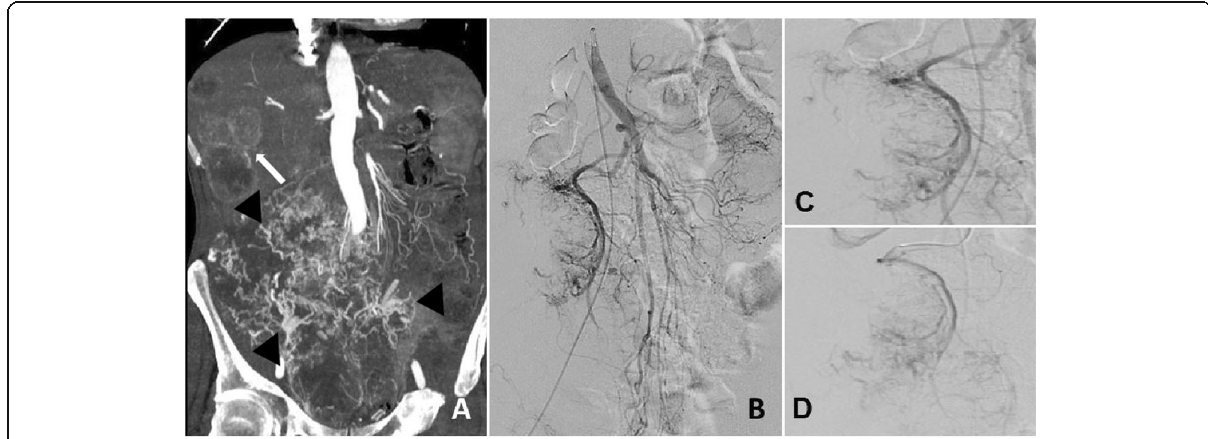
Fig. 2 a Coronal maximum intensity projection (MIP) reformatted CT image for a patient with massive small bowel GIST shows the extensive vascularity of the tumor (black arrow heads) and associated hepatic metastatic deposits (white arrow). b Aortogram shows the tumor neovascularity predominantly from the GDA and to less extent SMA. c Zoomed GDA angiogram shows the pre-embolization neovascularity and tumoral blush. d Post-embolization selective GDA angiogram demonstrates stasis and reduced tumoral